Question: Write a caption explaining this figure to a reader.
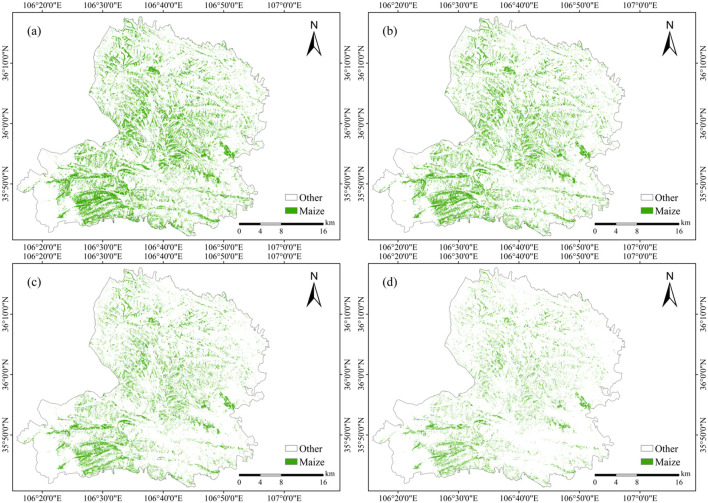
Answer: Spatial distribution extraction results obtained under varying threshold values using Random Forest (RF). (A) 0.65; (B) 0.70; (C) 0.75; (D) 0.80.